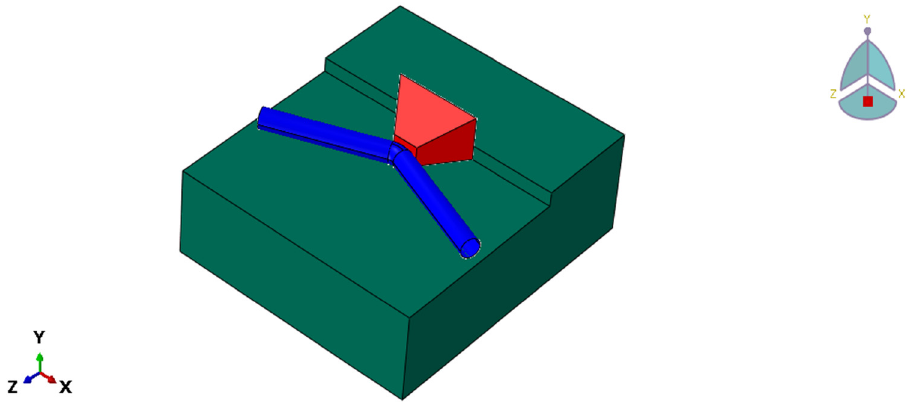
Figure 8: General view of Case 2.